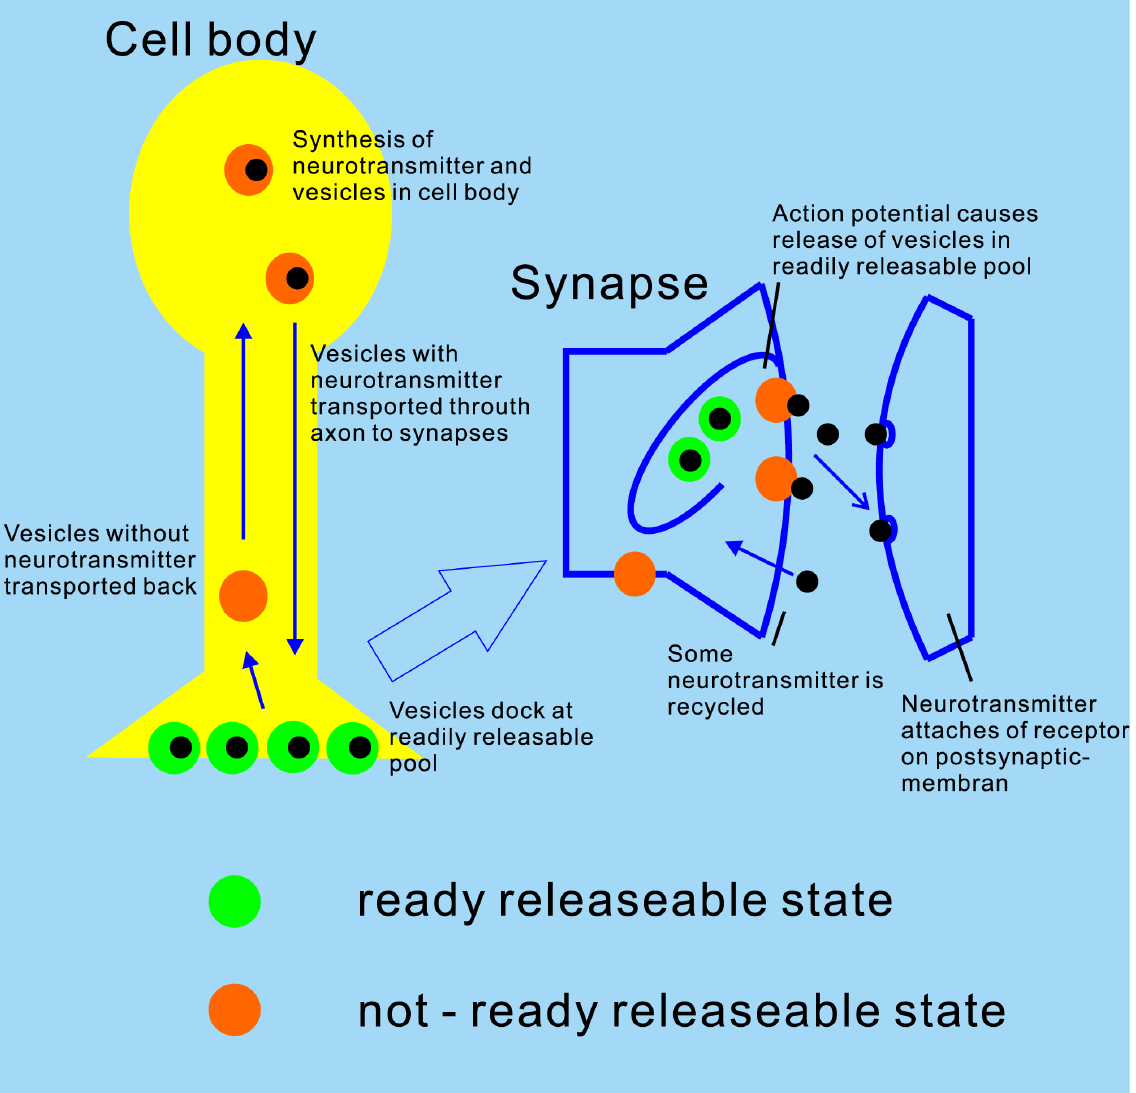
Figure 3. A simple sketch to show the releasing and recycling process of neural vesicles. We classify the vesicles as belonging to one of two states. Neural vesicles, which dock at the presynaptic membrane, are in readily releasable state (RR). Neural vesicles, which are under endocytosis and recycling processes are in not-readily releasable state (NRR).